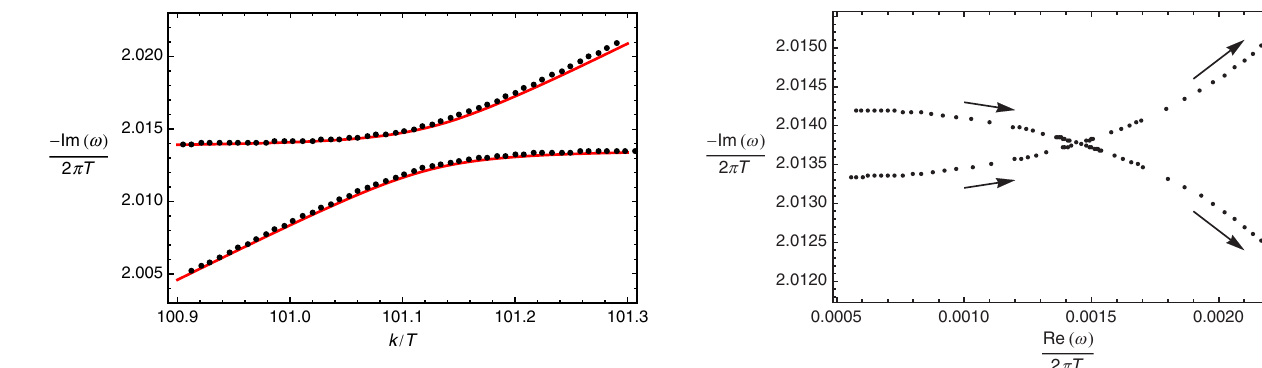
FIG. 3. Motion of the hydrodynamic (starting in the bottom left of the plot) and longest-lived infrared mode (starting in the top left of the plot) in the complex ω plane as j k j =T is increased (from approximately 101.09 to approximately 101.15) at fixed T=m ¼ 10 − 3 and fixed phase of the wave number ϕ ≃ 7 . 095 × 10 − 4 . k There is a collision for j k j ≃ 101 . 120 T . Equation (14) predicts a ≃ 7 . 374 × 10 − 4 . In Fig. S2 in collision at j k j ≃ 101 . 125 T and ϕ k Ref. [76], we show that the discrepancy between the numerical and analytical values from Eq. (14) decreases with